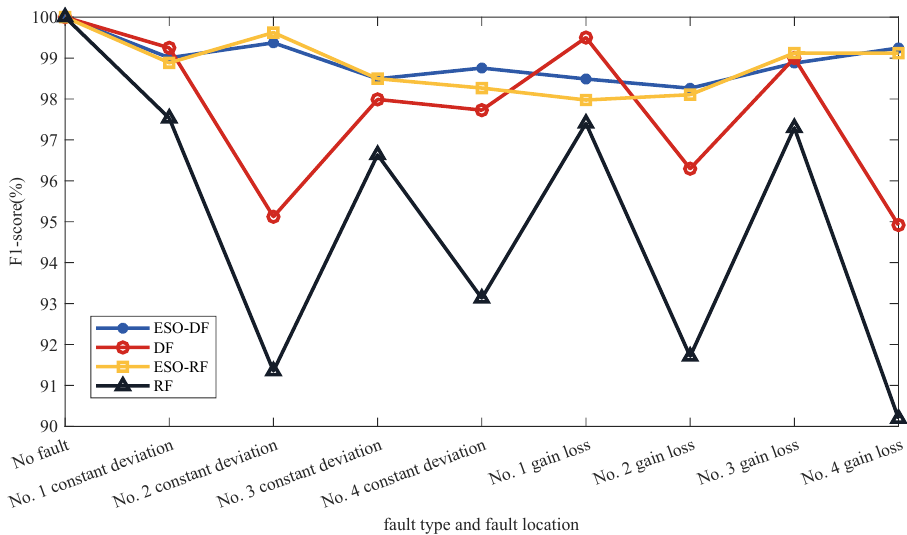
Figure 9. Fault diagnosis and fault localization F 1 scores of different